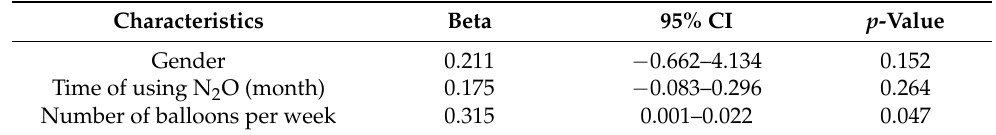
Table 4. Multiple Linear logistic between TNSc point with related factors.